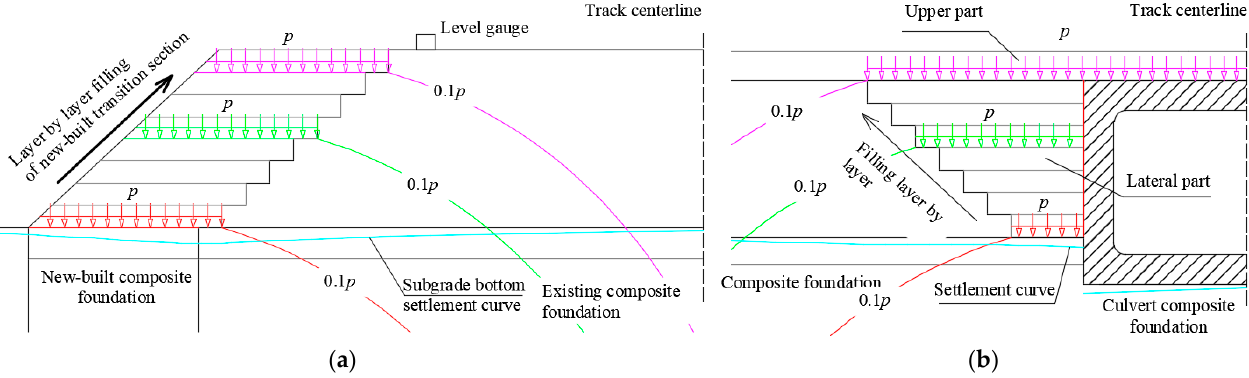
Figure 13. Relation curve of the level gauge settlement-filling-time: ( a ) Site1; ( b ) Site 2.